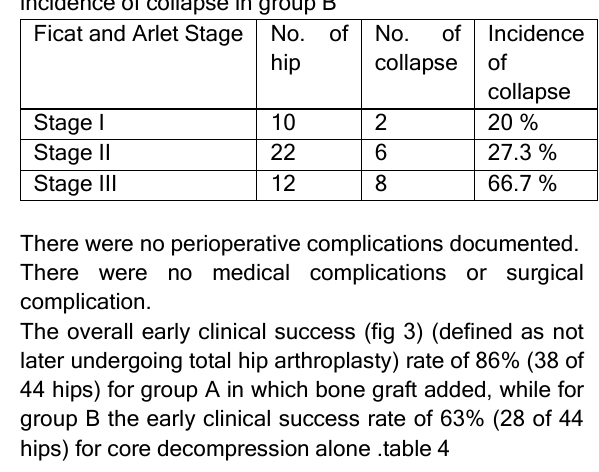
clinical & radiological outcome of